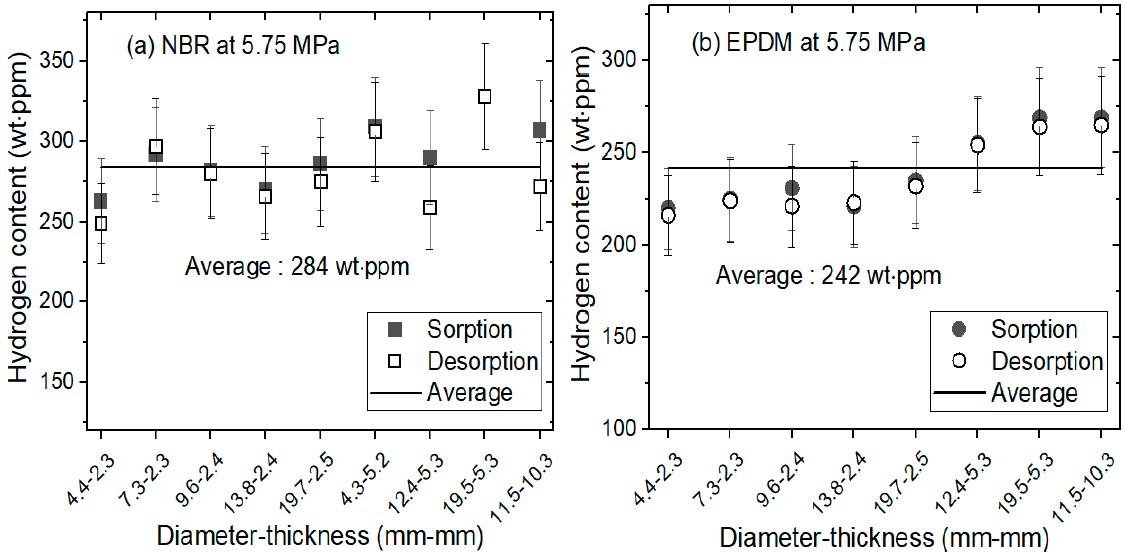
Figure 3. Total hydrogen sorption ( C ∞ ) and desorption content ( C 0 ) versus sample volume for cylindrically-shaped ( a ) NBR and ( b ) EPDM exposed to 5.75 MPa and 296 K. C ∞ and C 0 were obtained by the sequences in Figure 2a,b, respectively, with the application of the diffusion analysis program.